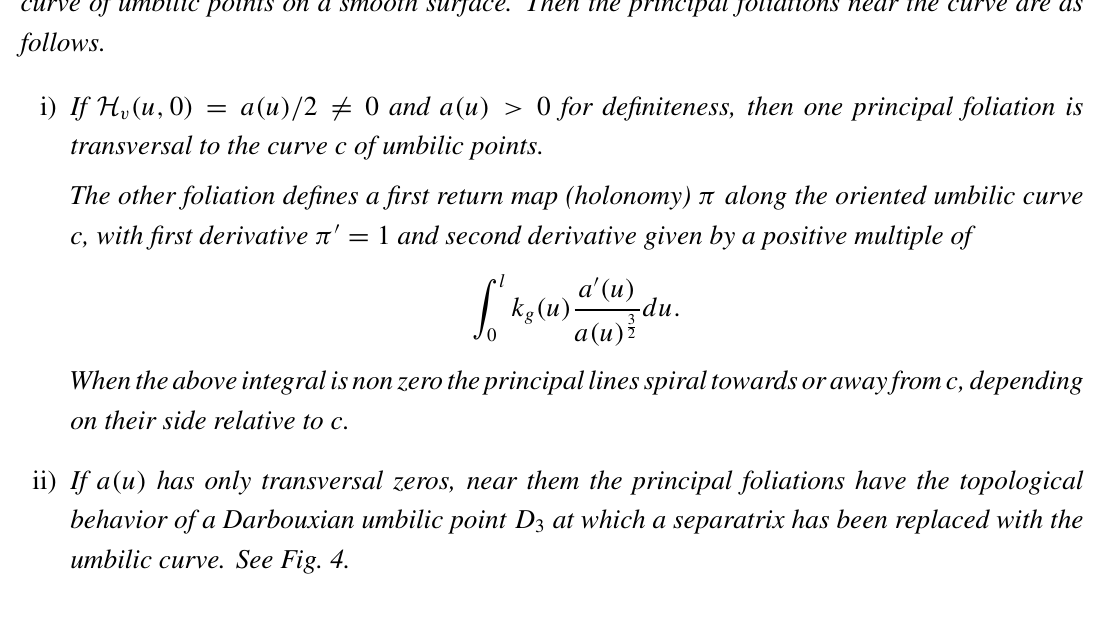
5 SPHERICAL AND PLANAR UMBILIC